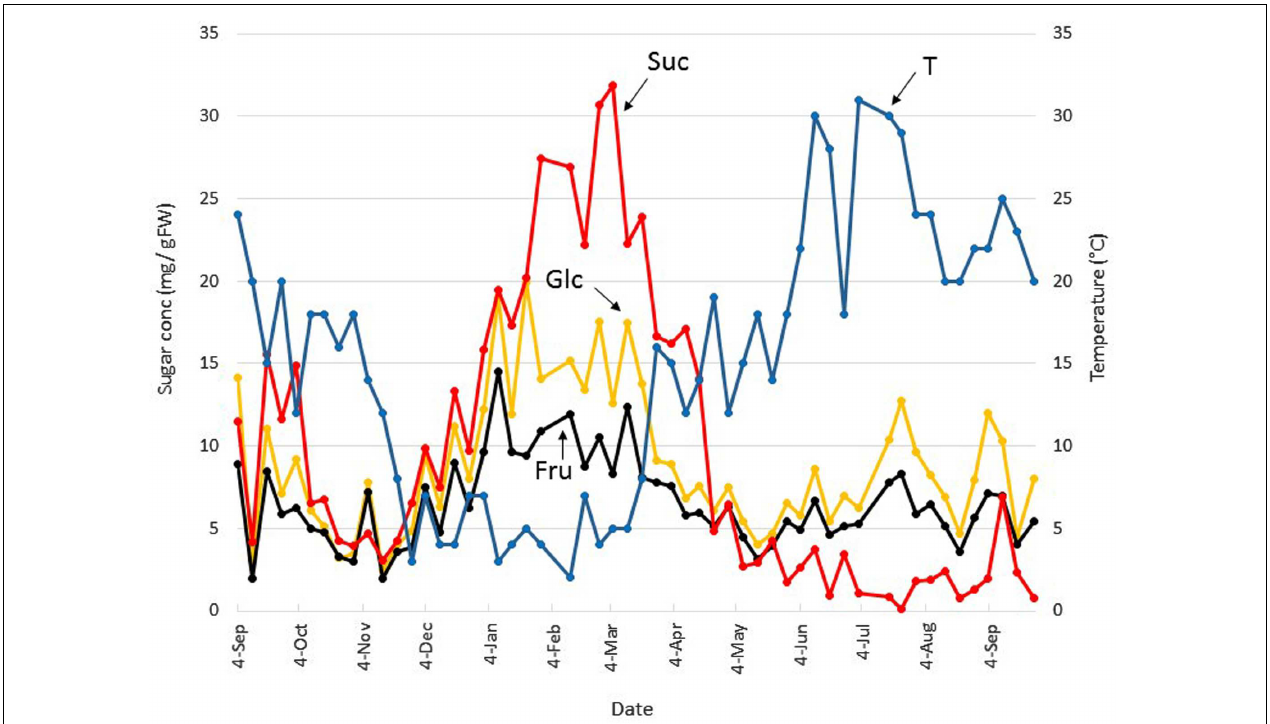
FIGURE 2 | Seasonal small soluble sugar dynamics in Belgian boxtree leaves. The concentrations of glucose (Glc, yellow), fructose (Fru, black), and sucrose (Suc, red) in Belgian boxtree leaves from a 70 year old tree (Langemark-Poelkappelle, Belgium) were followed on a weekly basis over a period of almost 13 consecutive months (left Y -axis). The mean temperature (T) over the same period is also depicted (blue, right Y